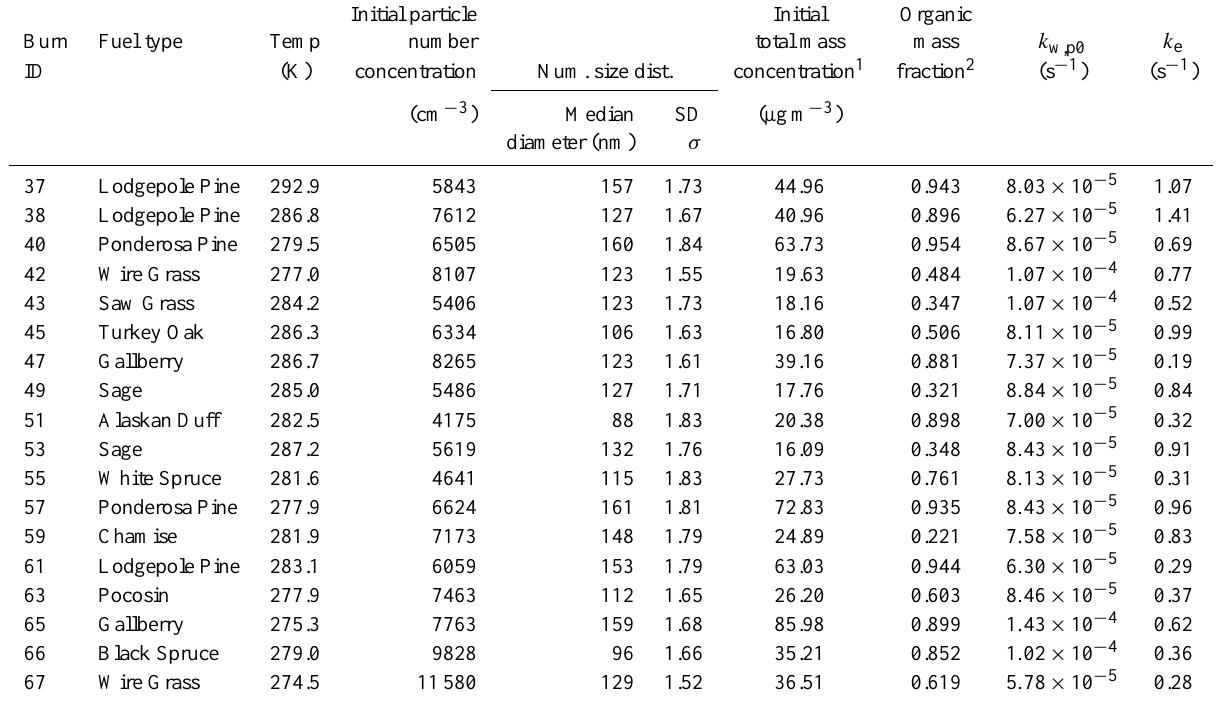
Table 1. Data for 18 wood-smoke samples introduced to the smog chamber, including fuel types, initial number concentration measured by scanning mobility particle sizer (SMPS) and corresponding size distribution parameters (median diameter in nm and standard deviation, σ ), initial total aerosol non-refractory mass concentration as measured by the Aerodyne quadruple aerosol mass spectrometer (Q-AMS), the organic mass fraction in the aerosol phase, derived turbulence rate ( k e , s − 1 ) and size-independent particle wall-loss coefficient ( k w,p0 , s − 1 ) used in the Aerosol Parameters Estimation (APE) model. The Burn ID refers to the schedule of burns in FLAME III, as reported in Hennigan et al. (2011). The initial time is taken as the end of the chamber filling period, equivalent to the start of the 75min mixing and characterization period, as described in the